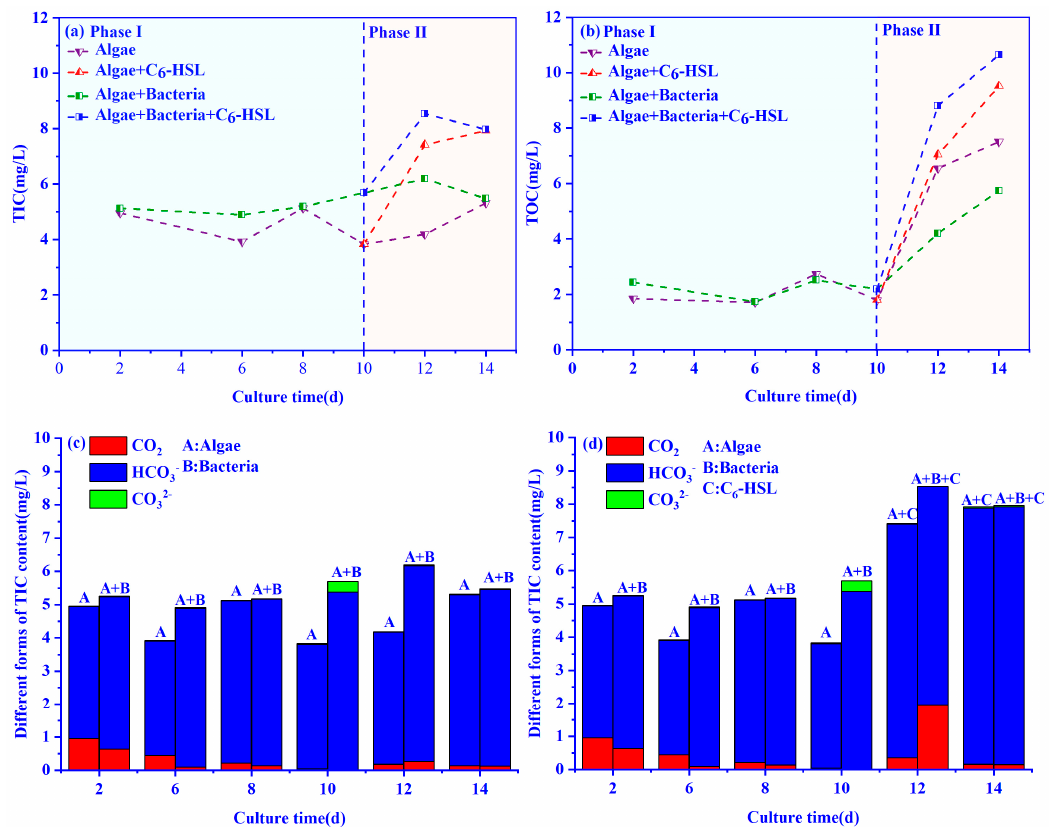
Figure 6. E ff ect of 10ng/L C 6 -HSL on ( a ) TIC and ( b ) TOC of algae group and algae–bacteria group. Algae+C 6 -HSL and algae+bacteria+C 6 -HSL are algae group and algae–bacteria group treated with C 6 -HSL, respectively. Phase I is without the addition of C 6 -HSL, and Phase II is with the addition of C 6 -HSL. Di ff erent forms of TIC concentrations of algae group and algae–bacteria group ( c ) without + B + C are algae group and algae–bacteria group treated with C 6 -HSL, respectively.